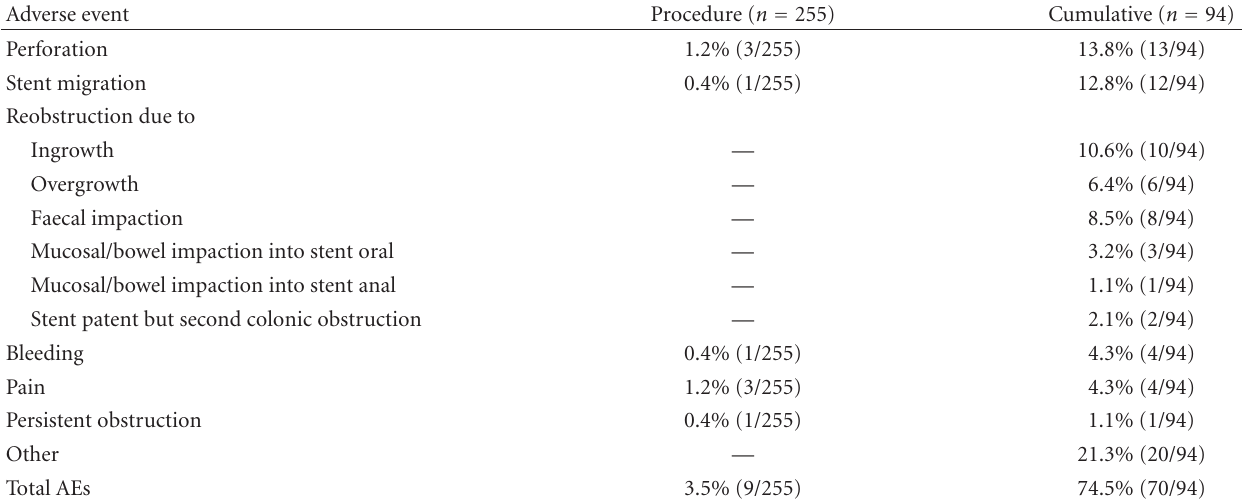
Table 3: Procedural and cumulative safety